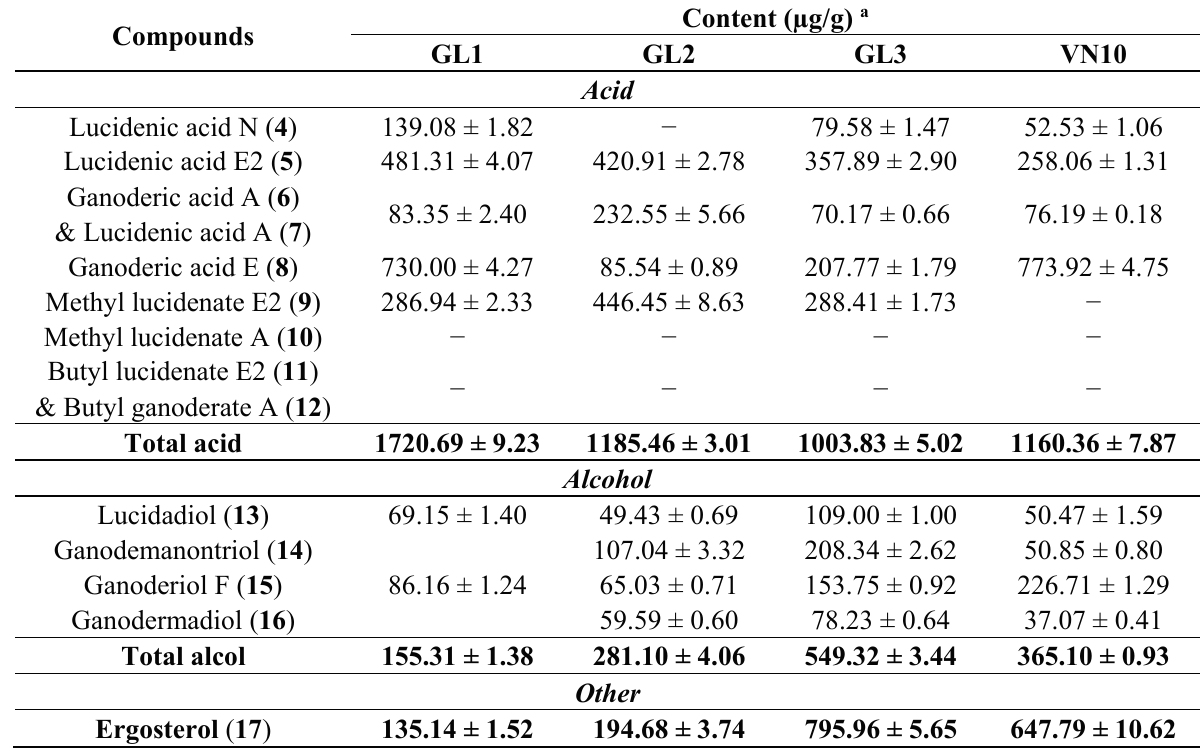
Table 5. Contents of 4 – 17 in the cultivated Linhzhi samples ( Group B ).